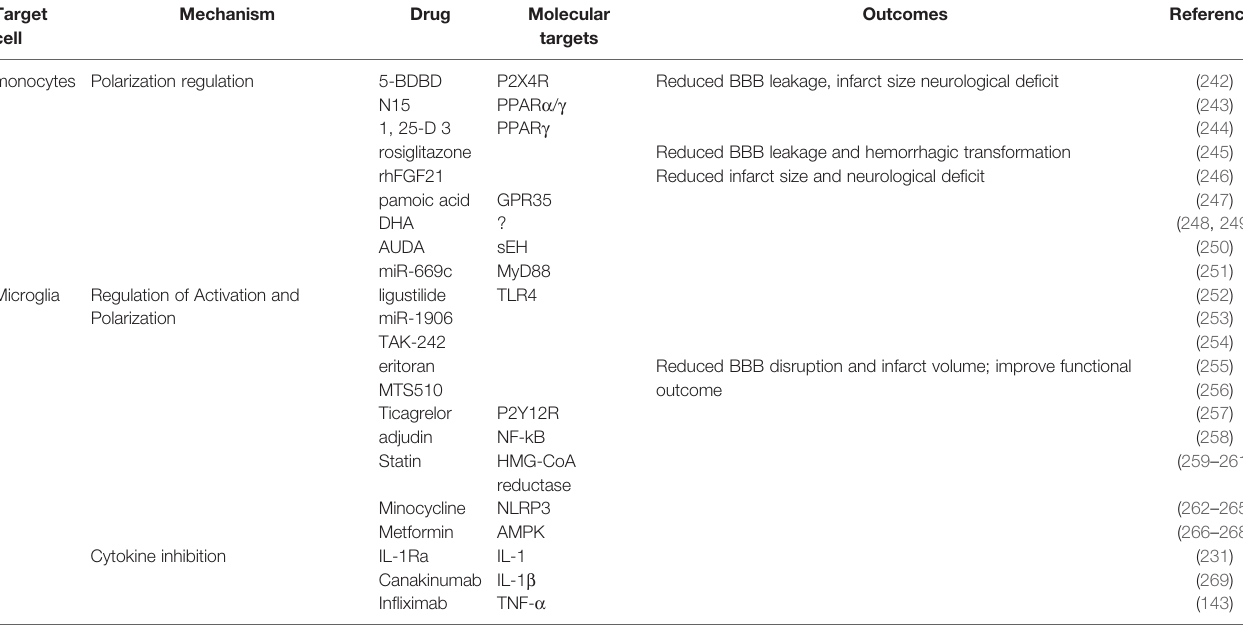
TABLE 3 | Preclinical attempts to target monocyte and microglia for treating AIS.